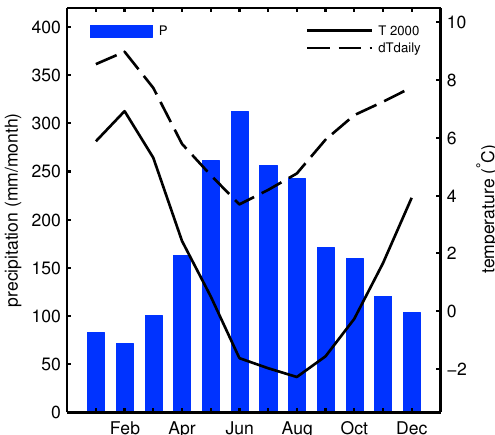
Fig. 3. 1980–2009 climatology of Glaciar Fr´ıas, from a combination of ERA-40 and ERA-interim data. Shown are the meteorological parameters needed for the mass balance model: monthly average temperature at 2000m (black), amplitude of the daily cycle (dashed black), and average monthly sum of precipitation at 850m